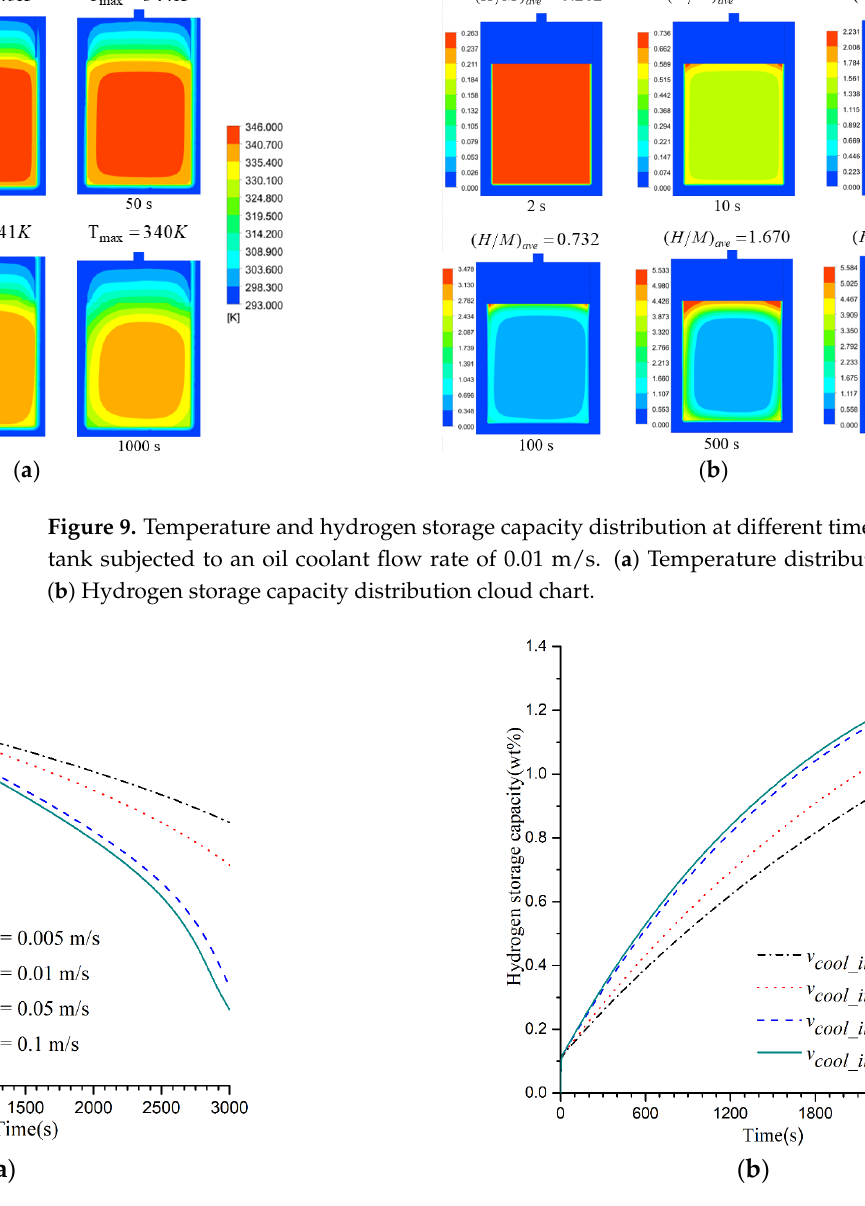
Figure 10. Time-varying curves of average temperature and hydrogen storage percentage by weight in the reaction zone subjected to different oil coolant flow rates. ( a ) Average temperature; ( b ) Percentage by weight.